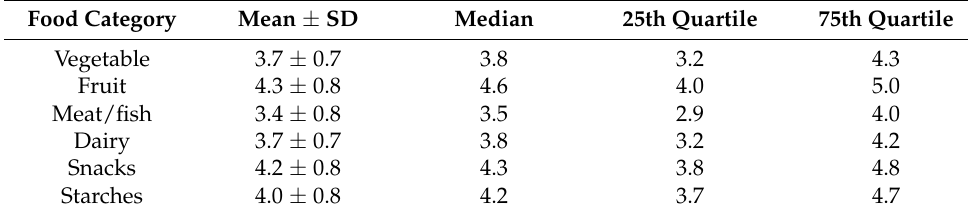
Table 2. The food preferences assessed by Food Preference Questionnaire (FPQ) within the population of the second phase of the Polish Adolescents’ COVID-19 Experience (PLACE-19) Study ( n = 2448) (distribution different than normal for all the variables verified using Shapiro-Wilk test— p ≤ 0.05).